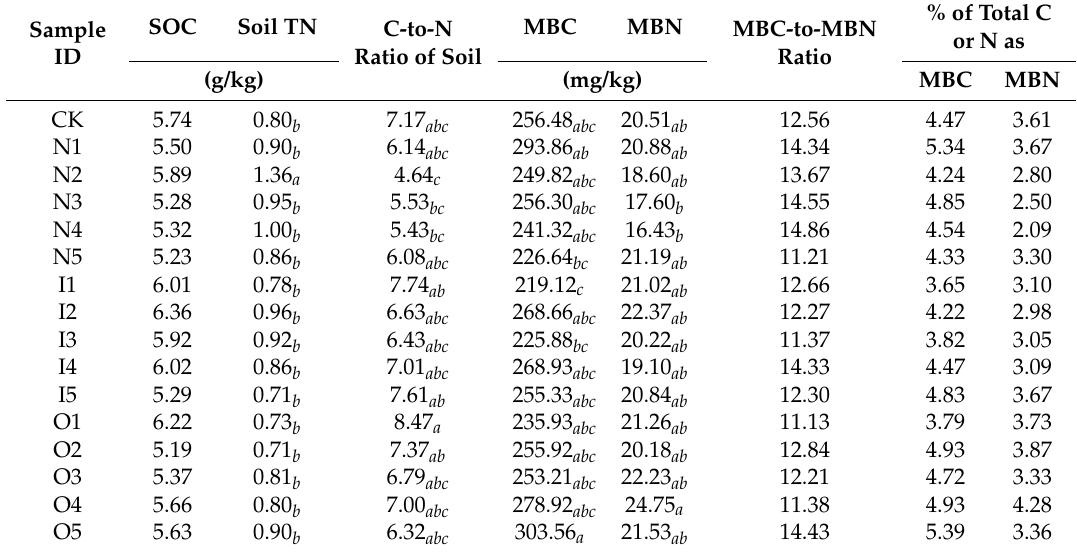
Table 3. The change of soil carbon and nitrogen of arable lands in spring.